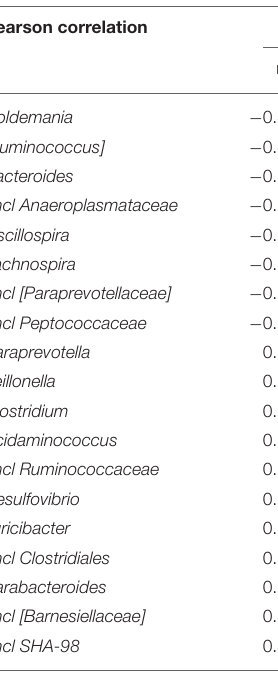
Acidaminococcus